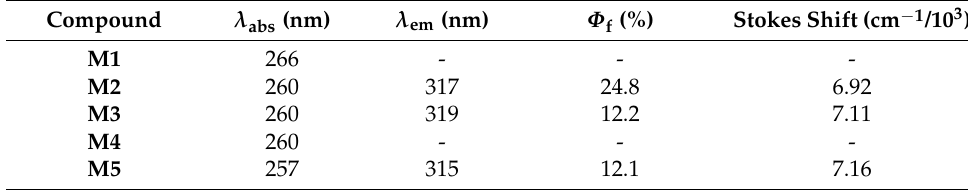
Table 1. Photophysical properties of M1–M5